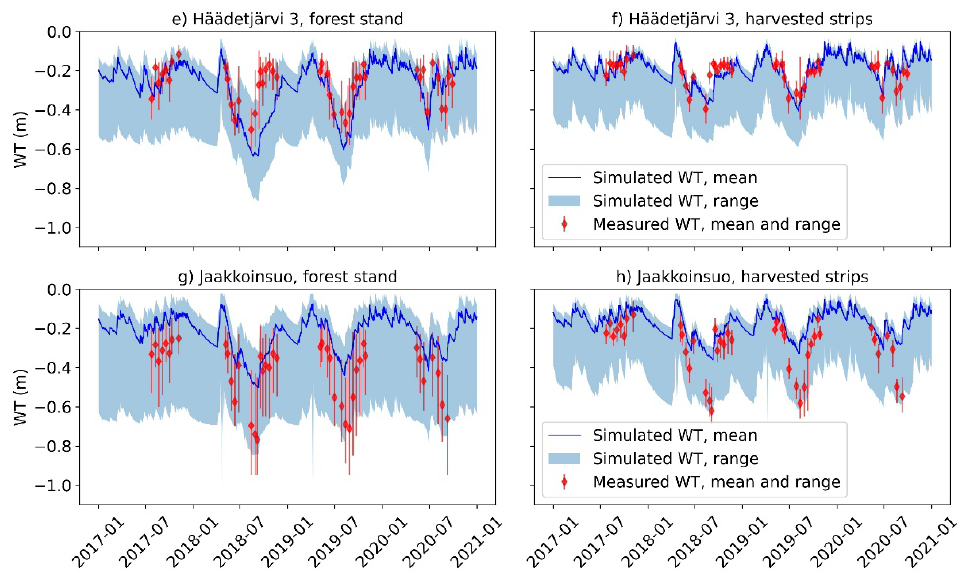
Figure A1. Simulated spatial mean and range of daily WTs in 2017–2020 and measured WTs within unharvested forest stand ( a , c , e , g ) and harvested (treeless) strips ( b , d , f , h ) at the study site. Measurement data from tubes located at the edge of forests and harvested strips were omitted. The simulated WTs’ ranges covered the whole forest or harvested area.